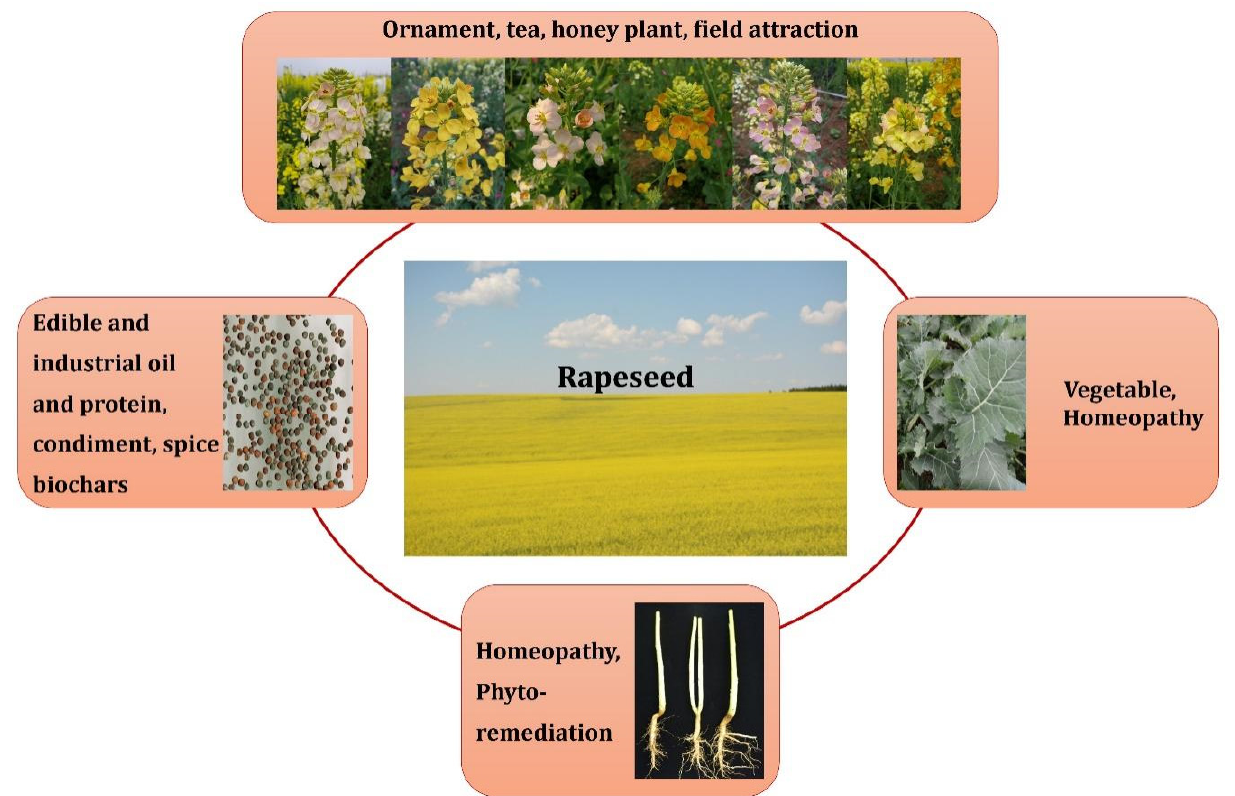
Figure 4. Global utilization of rapeseed.